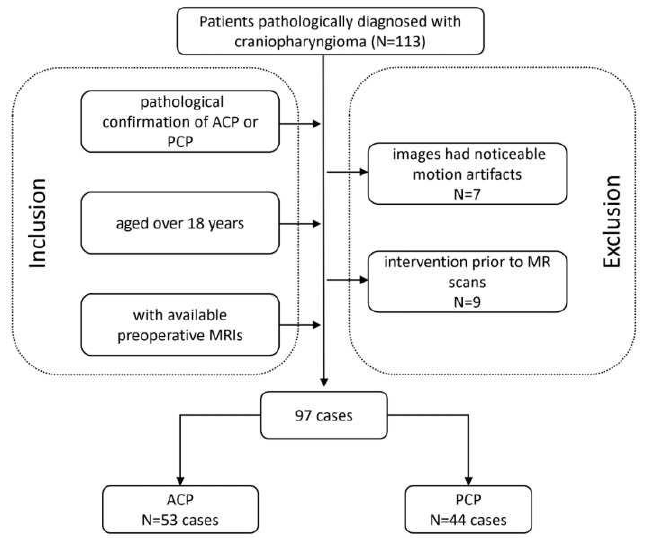
Figure 1. Flowchart of the involved population. ACP, adamantinomatous craniopharyngioma; PCP, papillary craniopharyngioma.